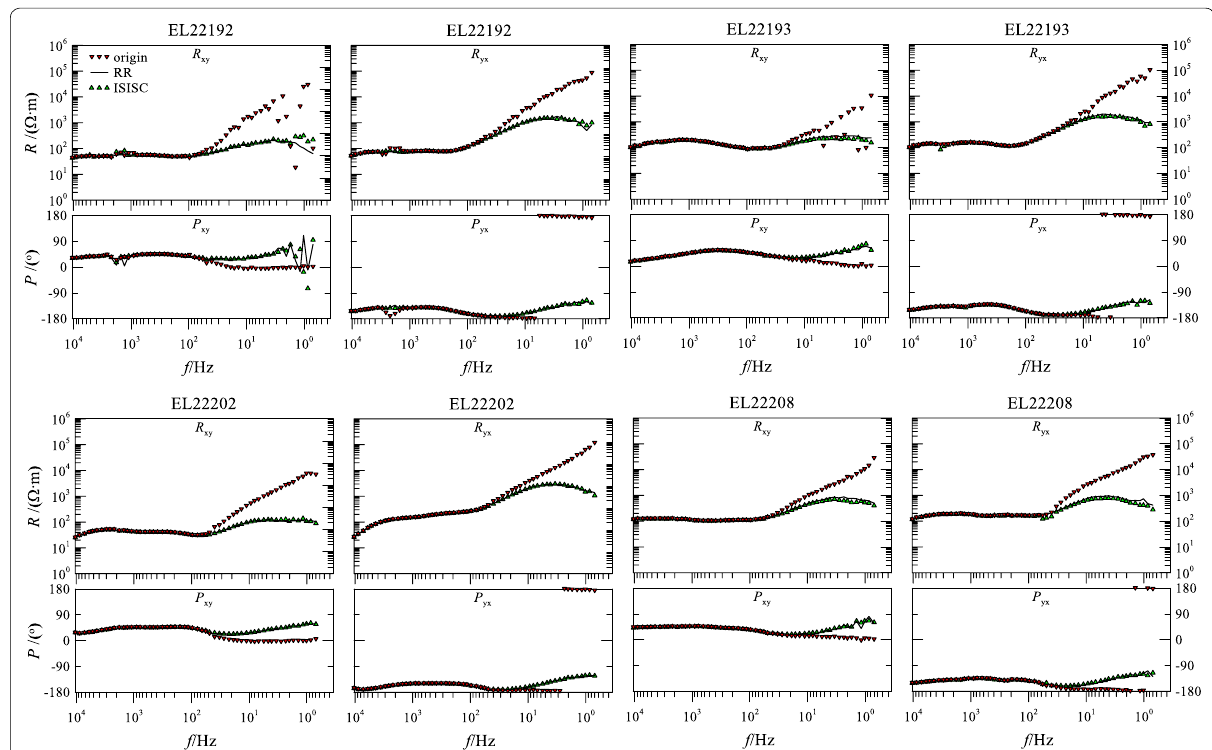
Fig. 12 Apparent resistivity and phase curves of the stations in Lujiang-Zongyang ore district. The upper panels are resistivity curves and the bottom panels are phase curves. The red curves with inverted triangles denote the results obtained using the raw noisy data, the black solid line represents the results obtained by remote reference method, the green curves with triangles stand for the results achieved by our new